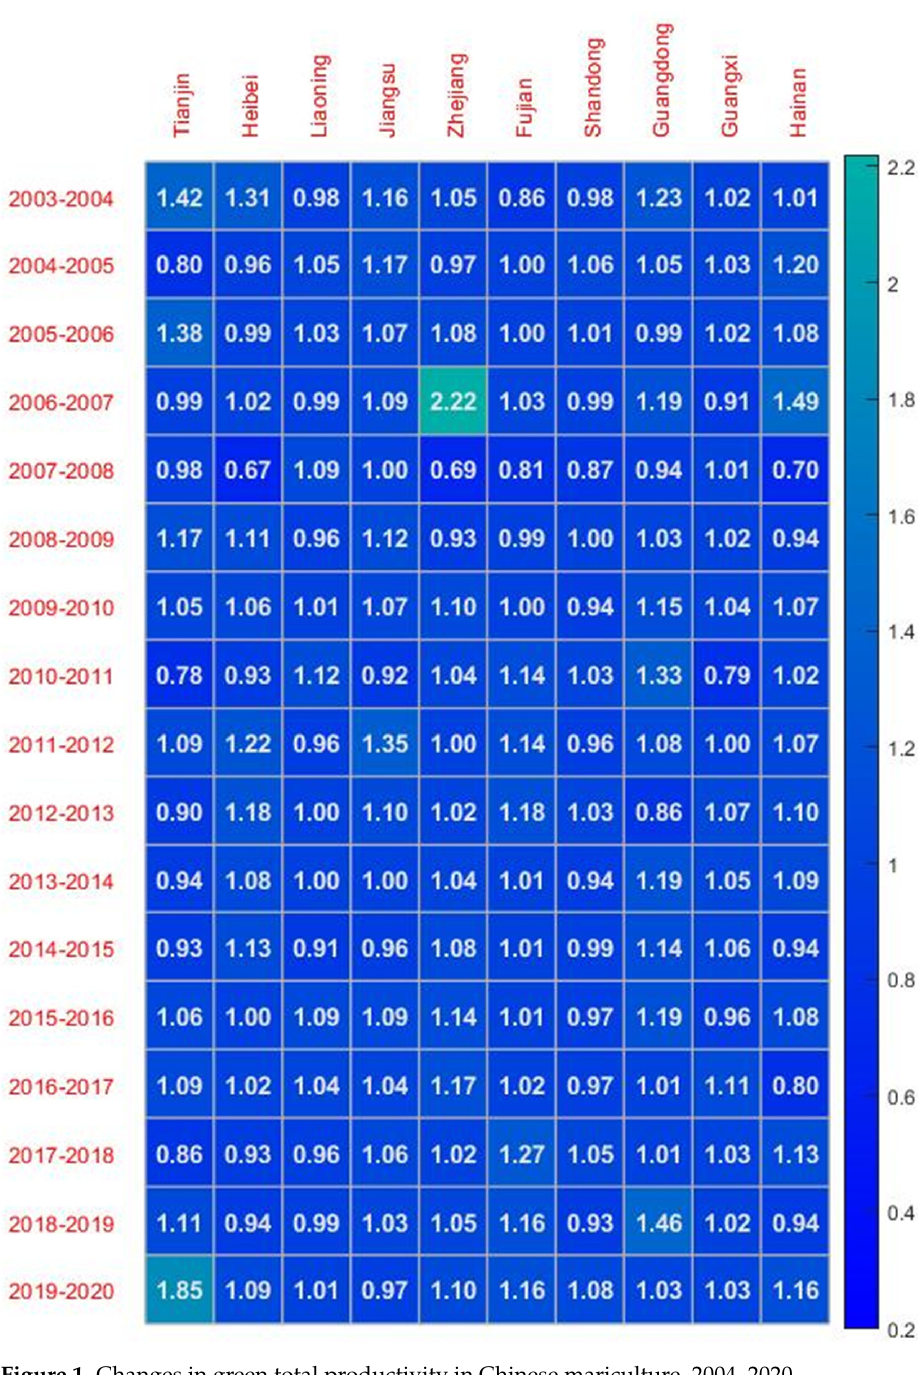
Figure 1. Changes in green total productivity in Chinese mariculture, 2004–2020.